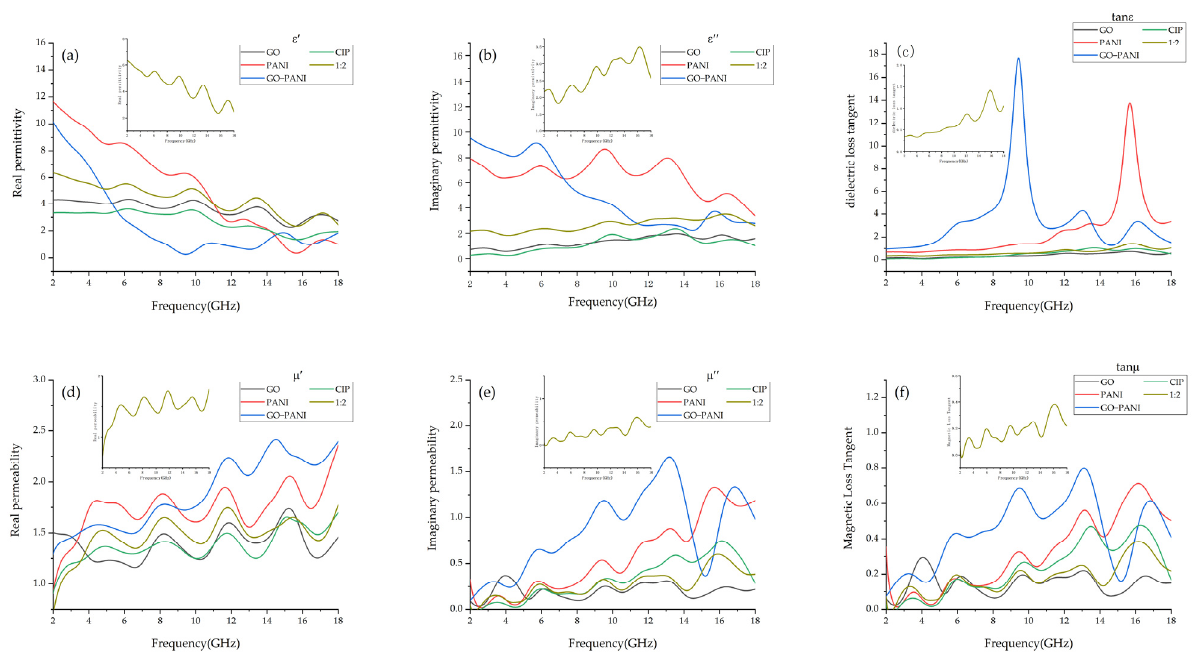
Figure 7. ( a ) Real permittivity, ( b ) imaginary permittivity, ( c ) dielectric loss tangent, ( d ) Real permeability, ( e ) imaginary permeability and ( f ) magnetic loss tangent of GO, PANI, GO-PANI, CIP and GO-PANI:CIP = X:Y (X and Y are the ratios in the Figure above). The dielectric loss tangent tan δ represents the overall dielectric loss. The larger the loss angle δ , the larger tan δ , and the electromagnetic energy is converted into heat.